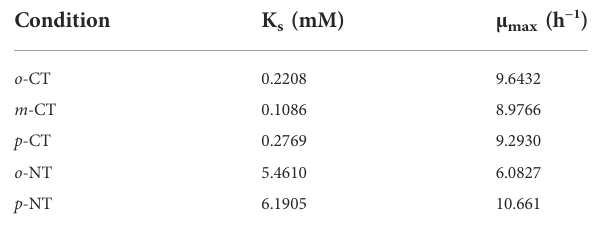
TABLE 1 Summary of the values of half-saturated constant (Ks) and maximumspeci fi cbioluminescenceproducingrate(SBR;µ max )for the KG1206 recombinant